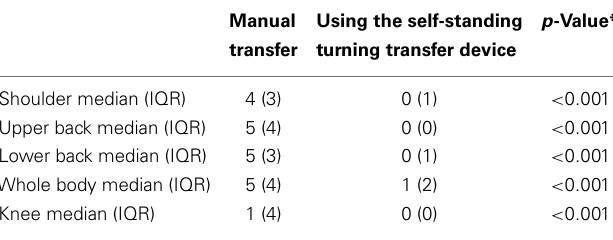
Table 3 | Physical stress-rating scores for manual and STurDi transfers .